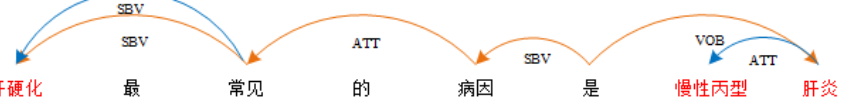
Figure 5. Diagram of the novel pruning strategy for fusion. SBV, subject–predicate relation; ATT, definitive–medial relation; VOB, verb–object relation. The Chinese sentence in the figure means “The most common cause of liver cirrhosis is chronic hepatitis C”. “ 肝 硬 化 ” represents “liver cirrhosis”, “ 最 ” represents “the most”, “ 常 见 ” represents “common”, “ 的 ” represents “of”, “ 病 因 ” represents “cause”, “ 是 ” represents “is”, “ 慢 性 丙 型 ” represents “chronic C”, “ 肝 炎 ” represents